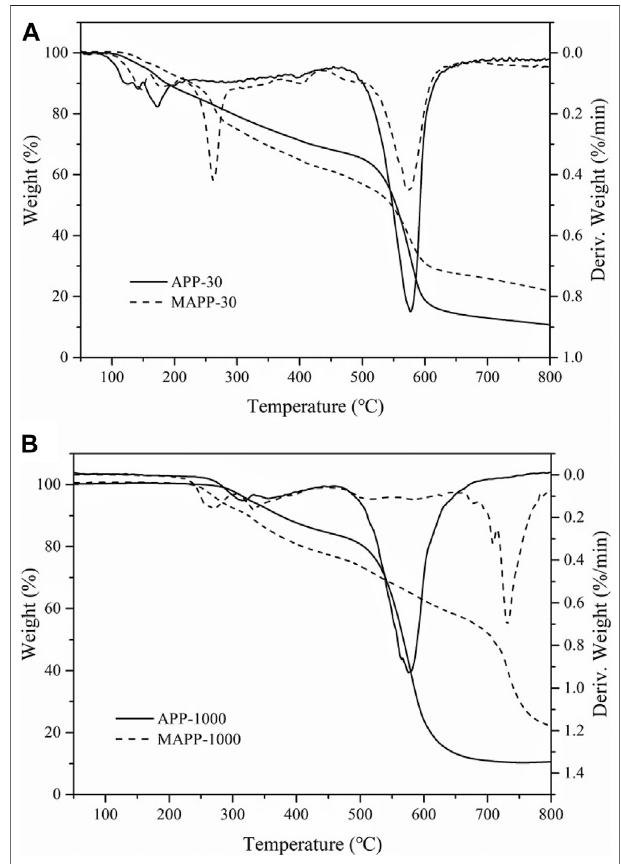
FIGURE 4 | TGA and DTG curves of APP-30, MAPP-30 (A) , and APP- 1000, MAPP-1000 (B) .